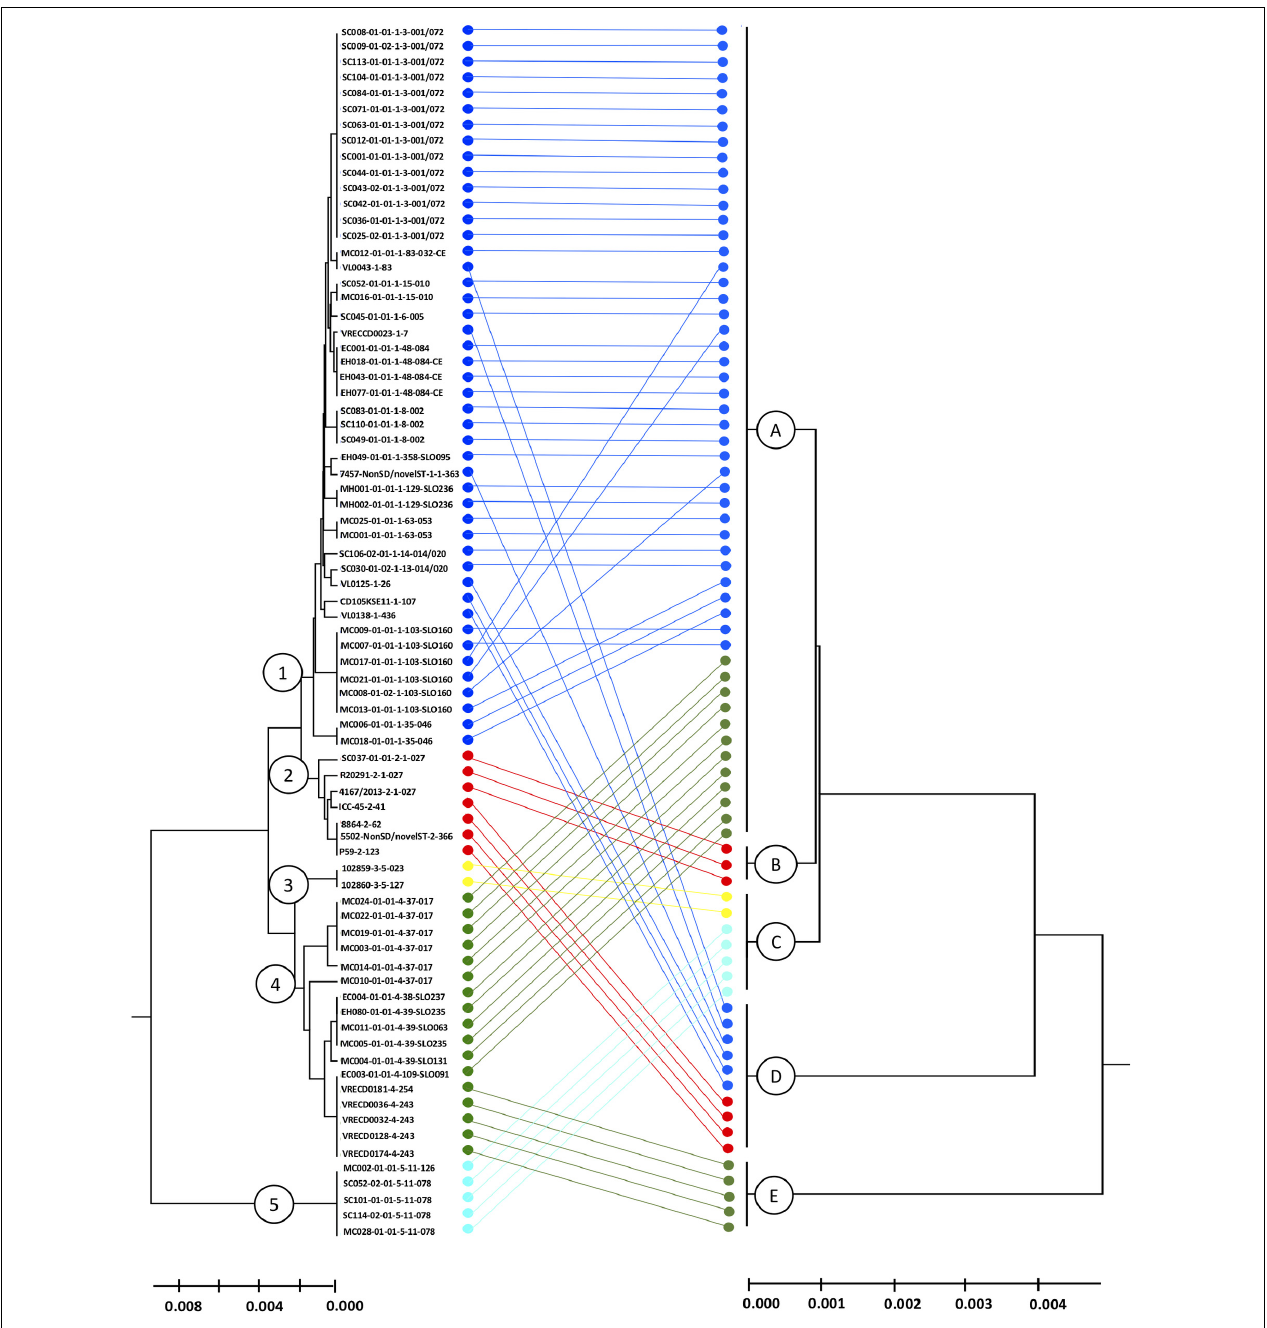
FIGURE 4 | Comparison of MLST- and proteotyping-derived phylogenies. Left tree: MLST-based evolutionary tree using the UPGMA method (maximum composite likelihood method). The isolates of the clades 1-5, indicated by different colors, form coherent clades. Here, the isolates of the clades 1 and 2 as well as the clades 3 and 4 form superclades while the clade 5 remains for itself. Right dendrogram: Proteotyping-derived UPGMA-tree. Here, too, the isolates are arranged in five clades, which, however, do not correspond to the MLST clades. Especially noteworthy is the proteotyping-derived Clade B, which consists of exclusively hypervirulent RT027 isolates, also forming a separate MLST clade (clade